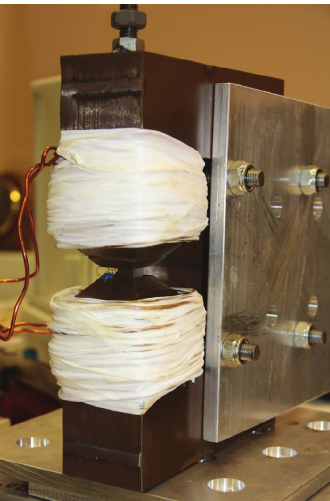
Figure 2: The iron yoke for testing materials in homogenous magnetic field